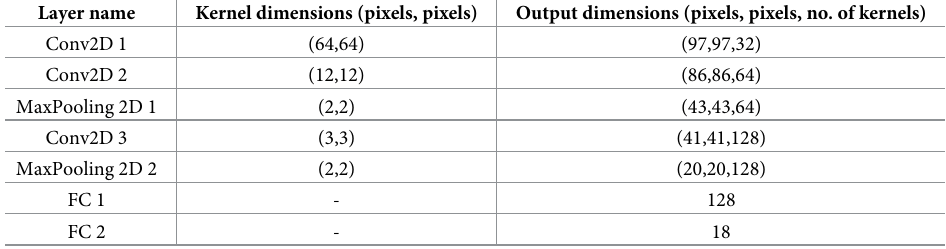
Table 1. The parameters of the 2D CNN model for the three projections of each testing curve which approximates the position of the FBG